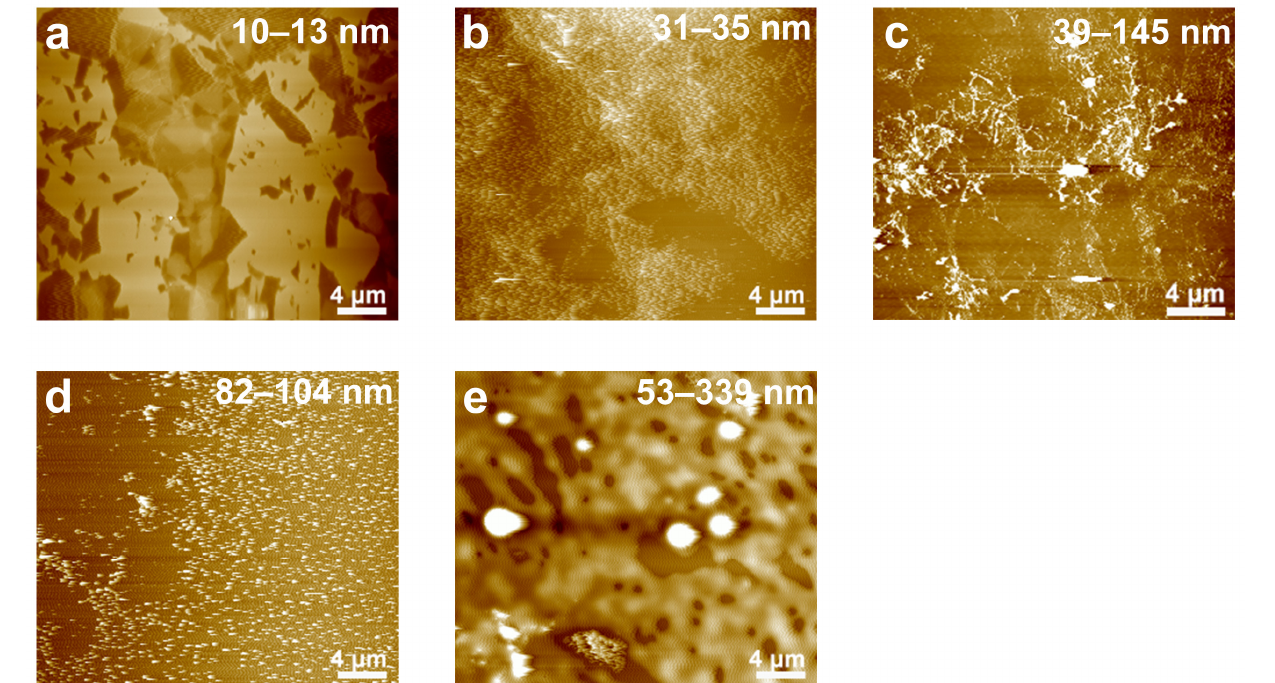
Figure 2. The AFM images of ( a ) GO/HCl-0, ( b ) GO/HCl-0.012, ( c ) GO/HCl-0.12, ( d ) GO/HCl-1.2, and ( e ) GO/HCl-12. and ( e )